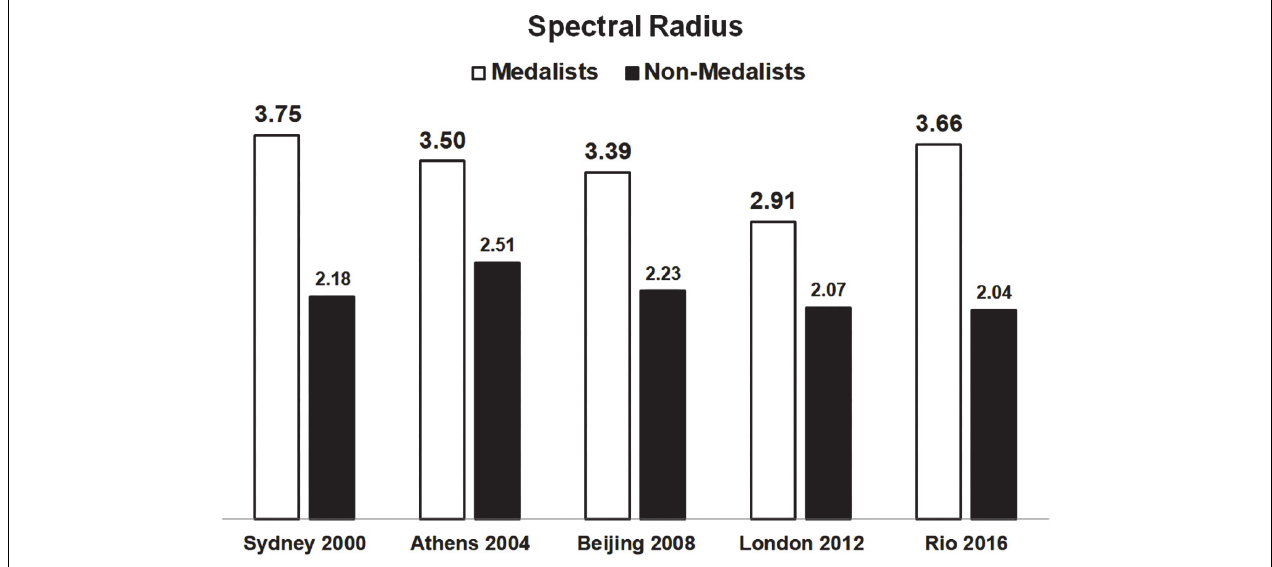
FIGURE 3 | The Spectral Radius (SR) network ( y -axis) by Olympic edition, comparing Medalists result (white) and non-medalists result (black). The Medalists – Winners network of each edition had the highest SR values at all competitions. It is worth mentioning that the winners always resulted in higher SR values at all editions analyzed, with significantly differences between groups (One-way ANOVA followed by Tukey HSD post hoc test, p < 0.05).